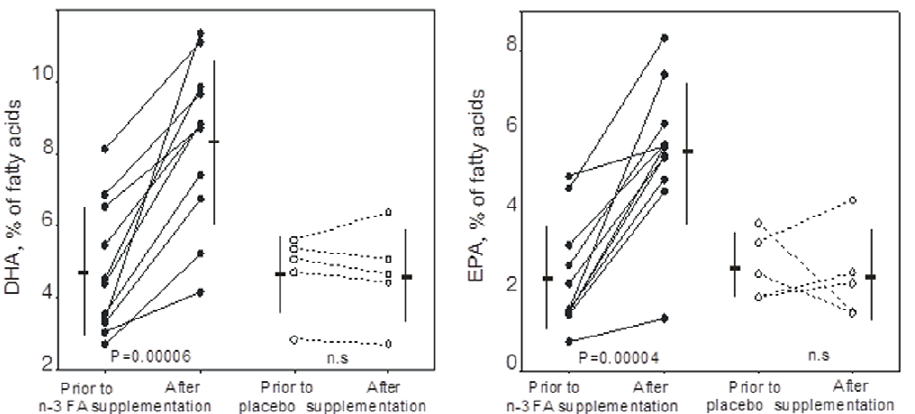
Figure 2. Plasma values for docosahexaenoic acid (DHA) and eicosapentaenoic acid (EPA) at baseline and after 6 months. Individual values are flanked by mean and SD values. Significant increases of DHA and EPA were noted in the n-3 fatty acids (n-3 FAs) group after 6 months, but not in the placebo group.